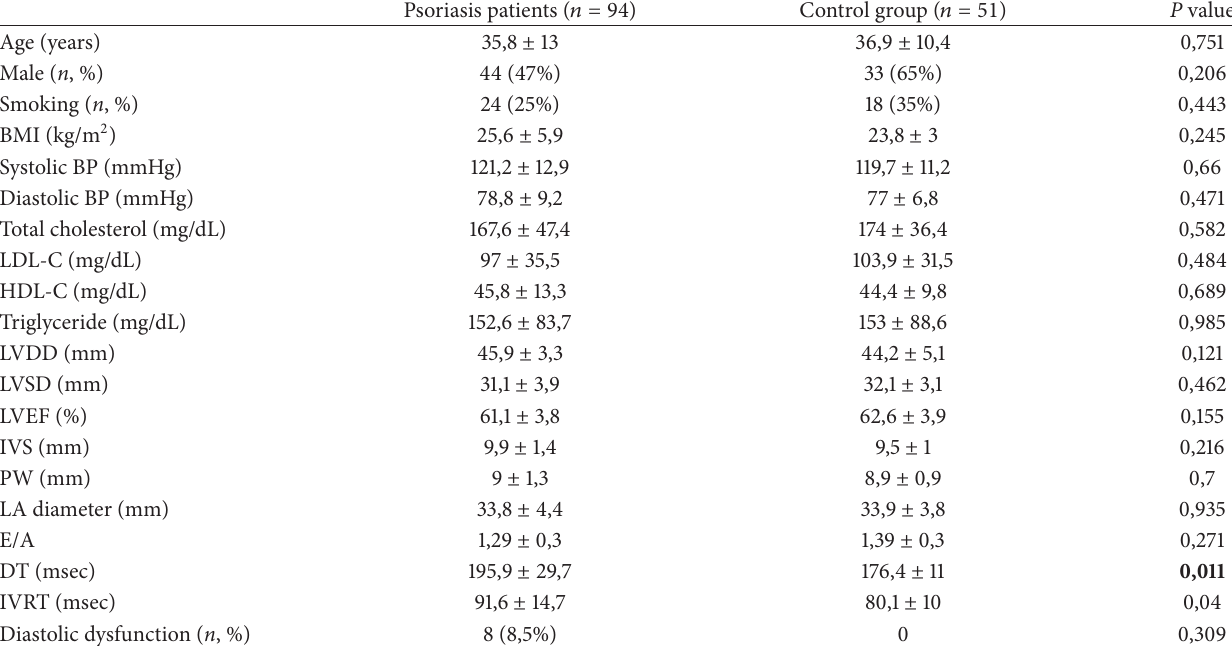
Table 1: Comparison of clinical, laboratory, and echocardiographic variables between psoriasis patients and healthy subjects.